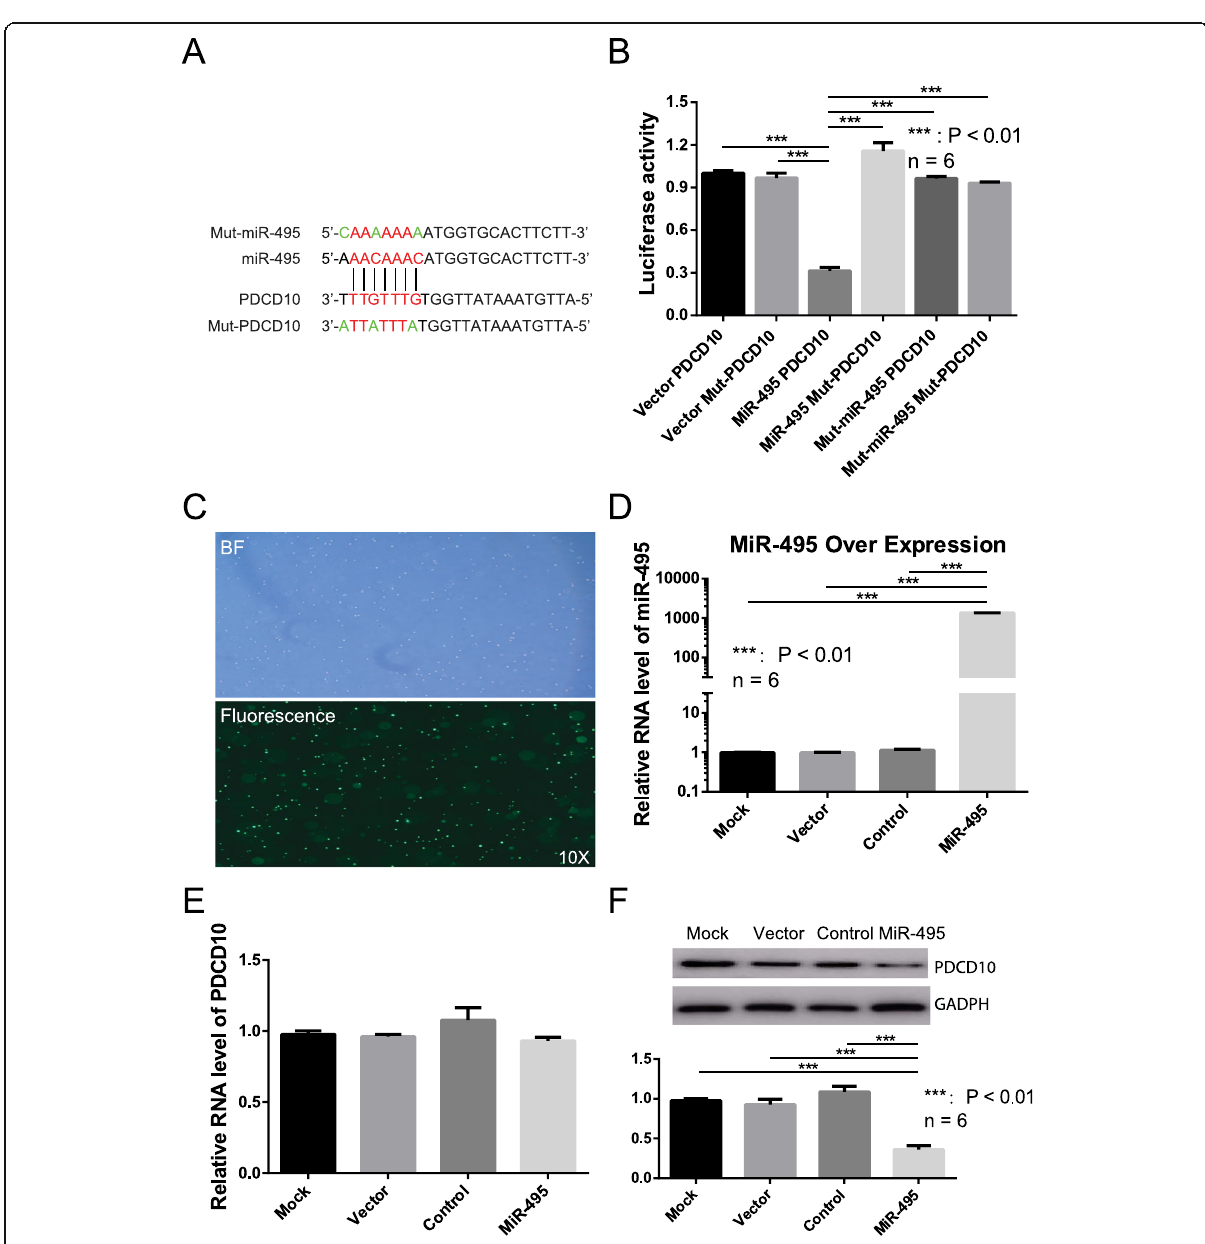
Fig. 4 Validation the interaction between PDCD10 and miR-495 . a Schema of the interaction between miR-495 and PDCD10 3 ′ UTR. Black vertical lines and red bases indicate the interacting regions. Mutated bases are marked with green letters. b Dual luciferase report assay results. Vector PDCD10 and VectorMut-PDCD10 indicate plasmid with wild-type and mutated PDCD10 3 ′ UTR, respectively. MiR-495 PDCD10 indicates the interaction between wild-type miR-495 and wild-type PDCD10 3 ′ UTR. MiR-495 Mut-PDCD10 indicates the interaction between wide type miR-495 and mutated PDCD10 3 ′ UTR. Mut-miR-495 PDCD10 indicates the interaction between mutated miR-495 and wild-type PDCD10 3 ′ UTR. Mut-miR-495 Mut-PDCD10 indicates the interaction between mutated miR-495 and mutated PDCD10 3 ′ UTR. c Transfection of primary PBMCs from AS. Top picture: bright field image of transfected PBMCs. Bottom picture: fluorescence image of transfected PBMCs. d Detection of miR-495 in transfected primary PBMCs from AS. Mock: untreated group. Vector: blank vector group. Control: mutated miR-495 over-expression group. MiR-495: miR-495 over-expression group. e RNA detection of PDCD10 in transfected primary PBMCs from AS. Mock: untreated group. Vector: blank vector group. Control: mutated miR-495 over-expression group. MiR-495: miR-495 over-expression group. f Western blot of PDCD10 in transfected primary PBMCs from AS. Mock: untreated group. Vector: blank vector group. Control: mutated miR-495 over-expression group. MiR-495: miR-495 over- expression group. n = 6: repeated times. ***: P value <